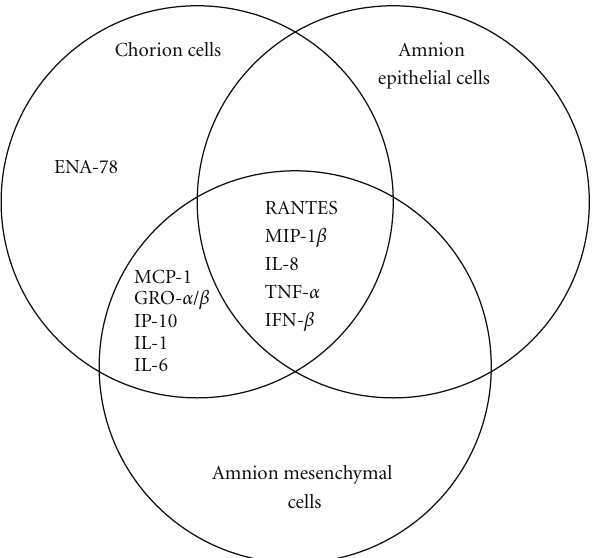
Figure 5: Di ff erential mRNA expression of chemoattractive cytokines and MDI factor among cultured chorion, amnion mesenchymal, and amnion epithelial cells in response to influenza virus infection. In cultured chorion cells, the levels of mRNA expression of all of 7 chemokines tested (i.e., ENA-78, MCP-1, GRO- α / β , IP-10, RANTES, MIP-1 β , and IL-8) were increased by influenza virus infection. In cultured amnion mesenchymal cells, the levels of mRNA expression of 6 chemokines except for ENA-78 (i.e., MCP-1, GRO- α / β , IP-10, RNATES, MIP-1 β , and IL-8) were increased. In cultured amnion epithelial cells, the levels of mRNA expression of 3 chemokines (RANTES, MIP-1 β , and IL-8) were increased. Influenza virus infection induced the expression of IL-1 β and IL-6 mRNAs in chorion and amnion mesenchymal cells but not in amnion epithelial cells. The expression of TNF- α and IFN- β mRNAs was induced in three types of cells by influenza virus infection. Abbreviations used: ENA-78, epithelial cell-derived neutrophil-activating protein 78; GRO- α / β , growth-related oncogene α / β ; IL, interleukin; IP-10, interferon inducible protein 10; MCP-1, monocyte chemoattractant protein 1; MDI, monocyte di ff erentiation-inducing; MIP-1 β , macrophage inflammatory protein 1 β ; RANTES, regulated on activation, normal T cell expressed and